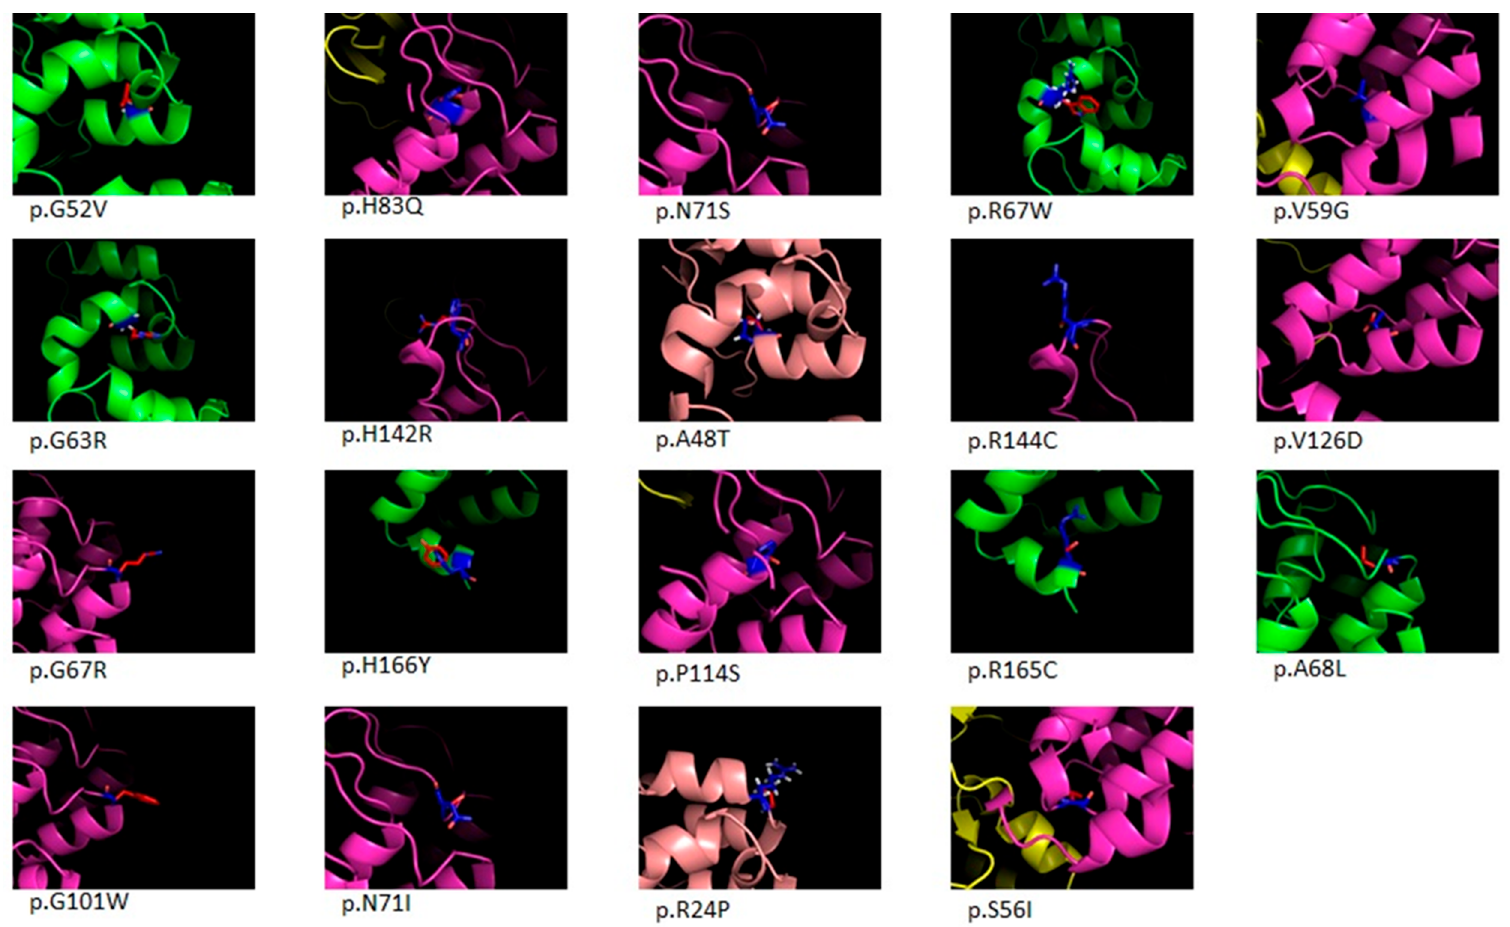
Figure 5. Molecular modeling analysis and localization of missense changes affecting p16 CDKN2A isoform. Proteins are represented as ribbons and colored according to protein chain. Wild-type and mutant residues are represented in blue and red sticks, respectively.